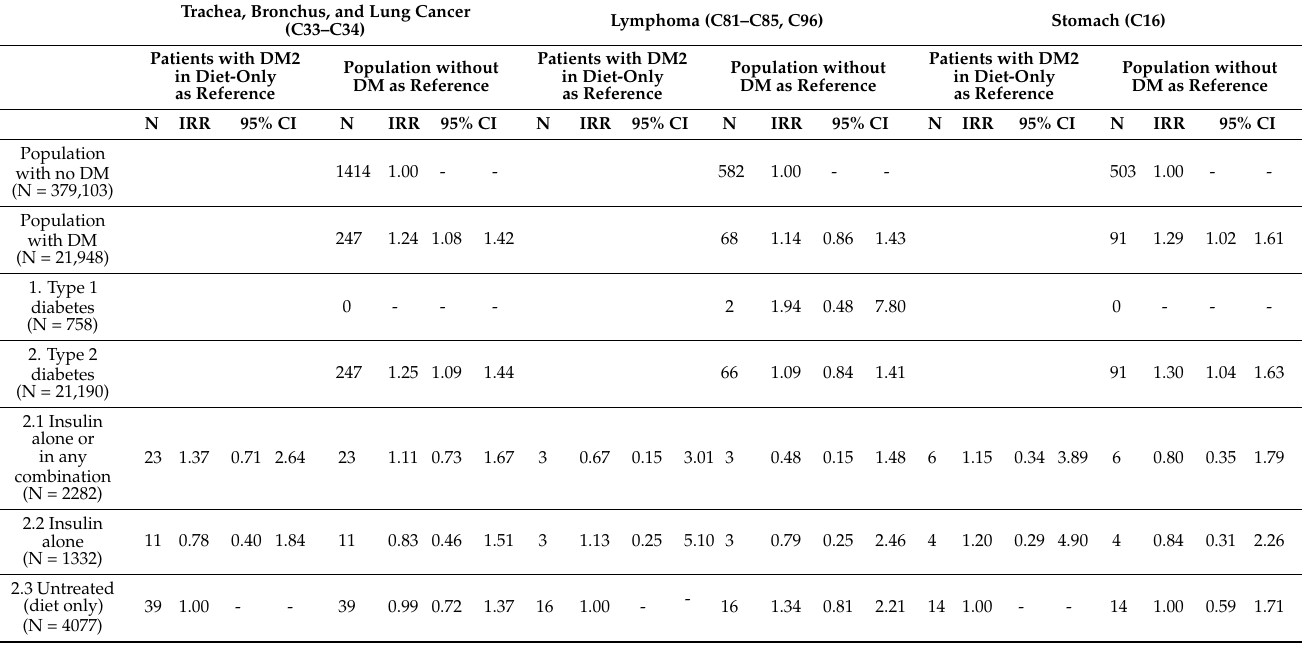
Table 4. Number, incidence rates ratios (IRR), and 95% confidence intervals (95% CI) of colorectal, pancreatic, liver, trachea, bronchus, and lung cancer, stomach cancer and lymphoma, corpus uteri, breast (women only), ovary, kidney, bladder, and prostate cancer by type of treatment with type 1 and type 2 diabetes (DM1; DM2). Reggio Emilia 2011-16, resident population aged 20–84 years. See Supplementary Material Table S6 for “other